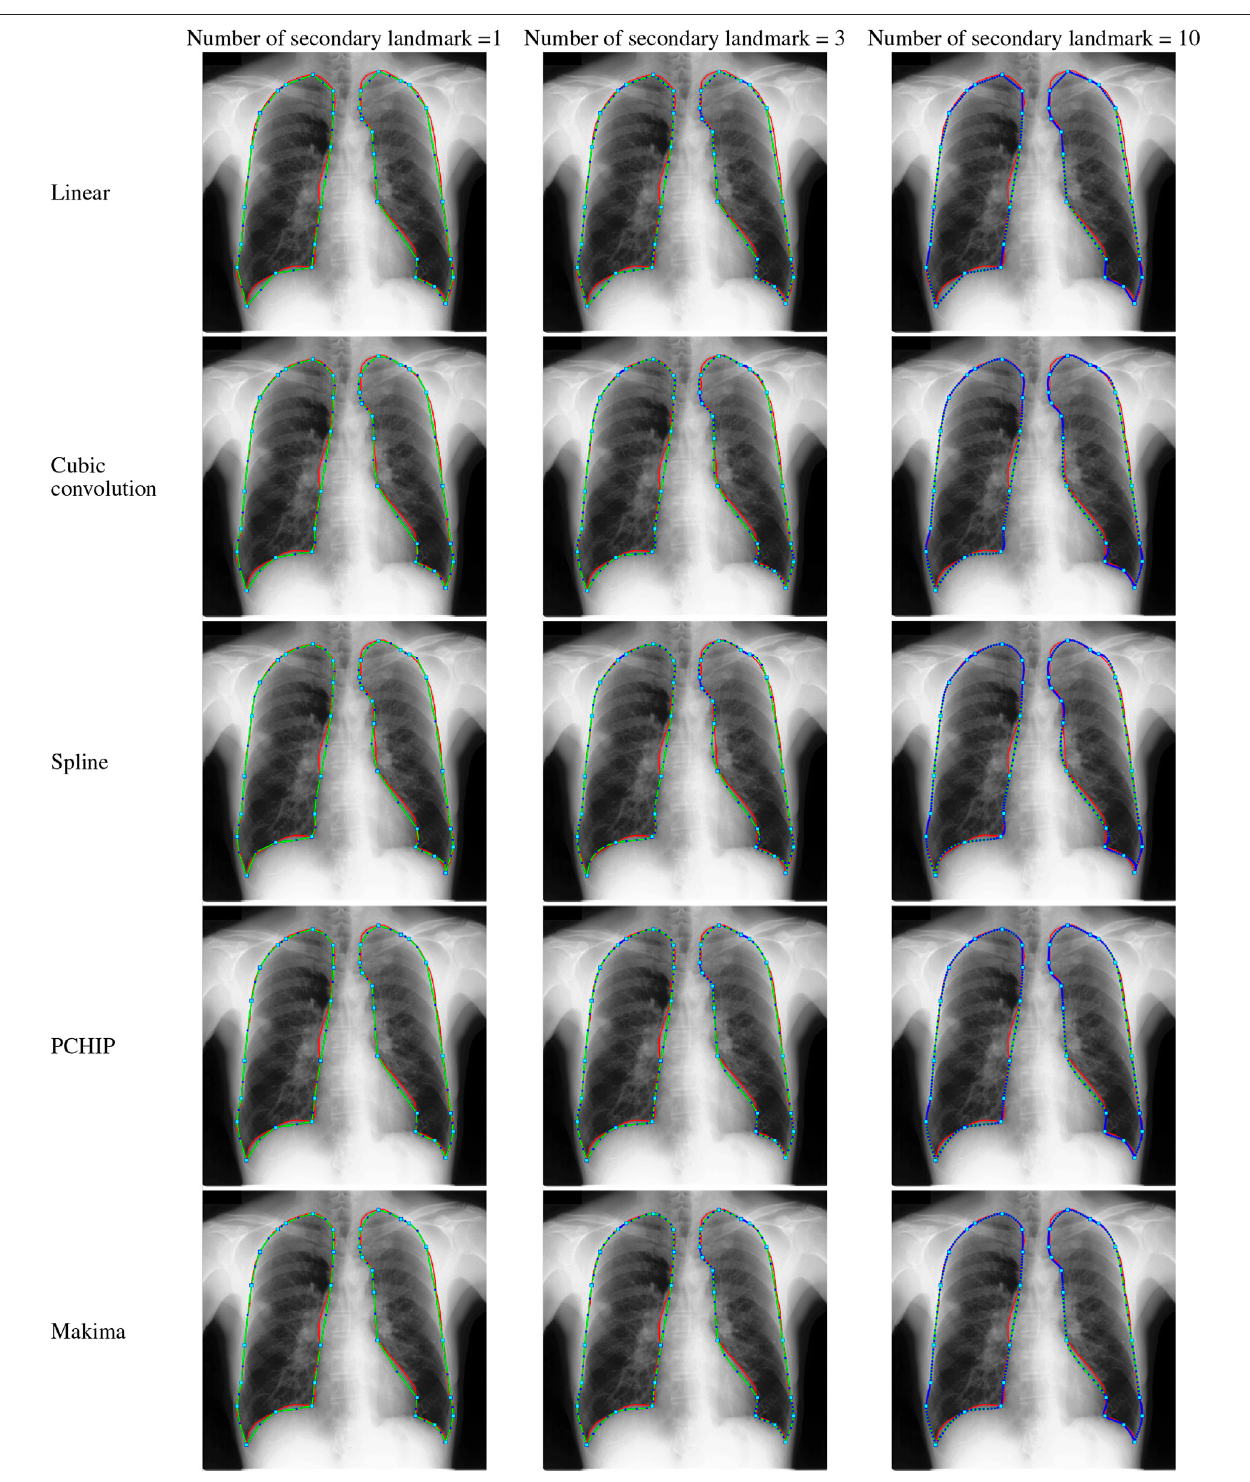
FIGURE 3 | Lungs region formation: ground truth (red) and the modeled shape (green) using different interpolating polynomials with 1, 3, and 10 intermediate semilandmark point(s) of the selected image dataset JPCLN007.